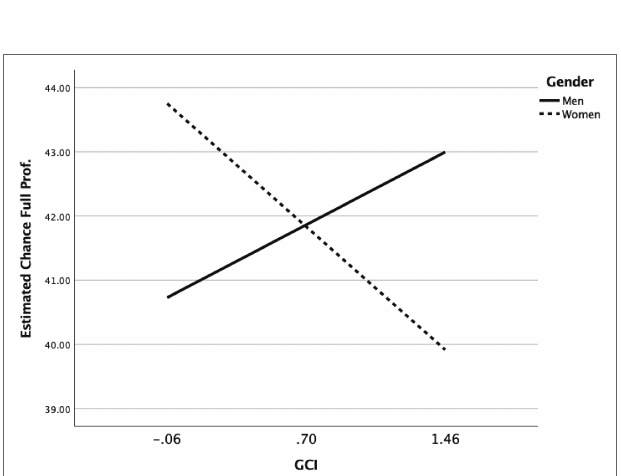
FIGURE 4 | Interaction effect Perceived GCI × Gender on Perceived odds (%) to become full professor (interaction points plotted at − 1 SD and +1 SD values from the mean GCI index).